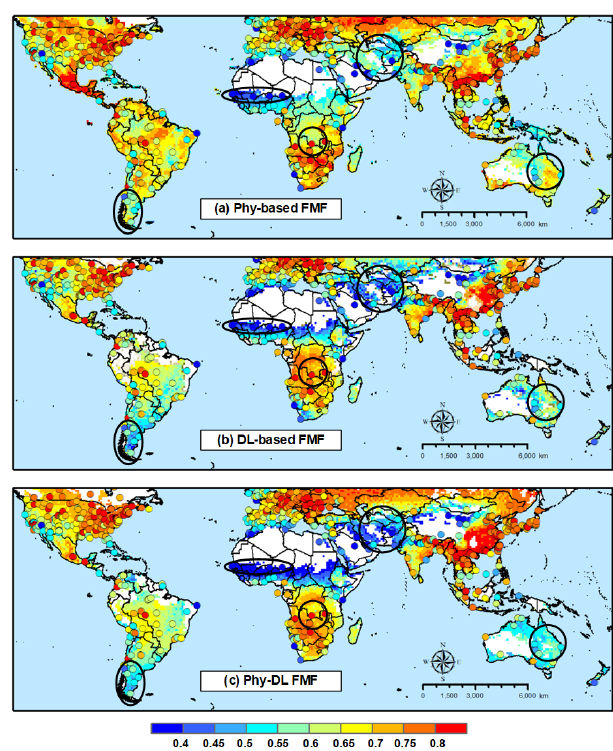
Figure 9. Annual mean (a) Phy-based FMF estimates, (b) DL- based FMF estimates, and (c) Phy-DL-based FMF estimates. The colored dots in (a) , (b) , and (c) show annual mean AERONET FMF. Areas outlined in black show regions with noticeably large differ- ences in the FMF estimates. Only those pixels with over 120 re- trievals per year were considered. Data from 2008 to 2017 were